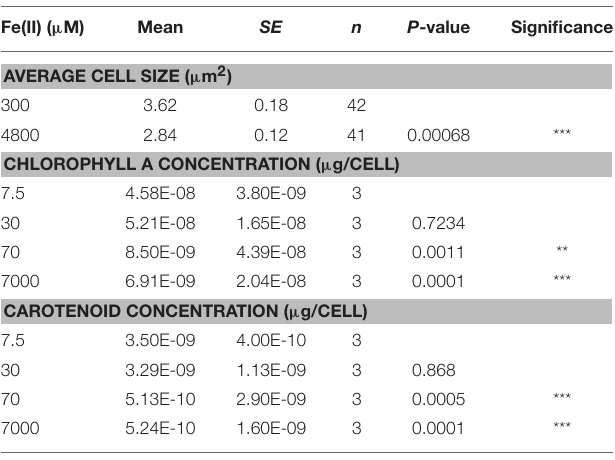
TABLE 1 | Difference in cell size and pigment concentrations when Synechococcus PCC 7002 was grown with different Fe(II) concentrations.